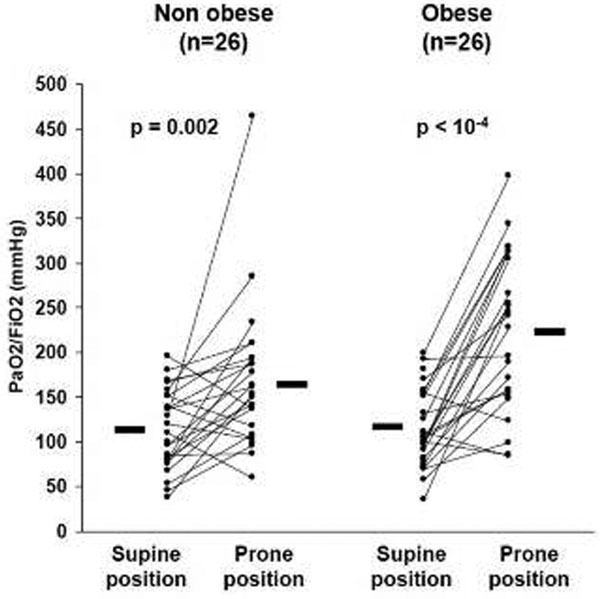
Individual variations of PaO2/FiO2 ratio between supine and prone positions in obese and nonobese patients.